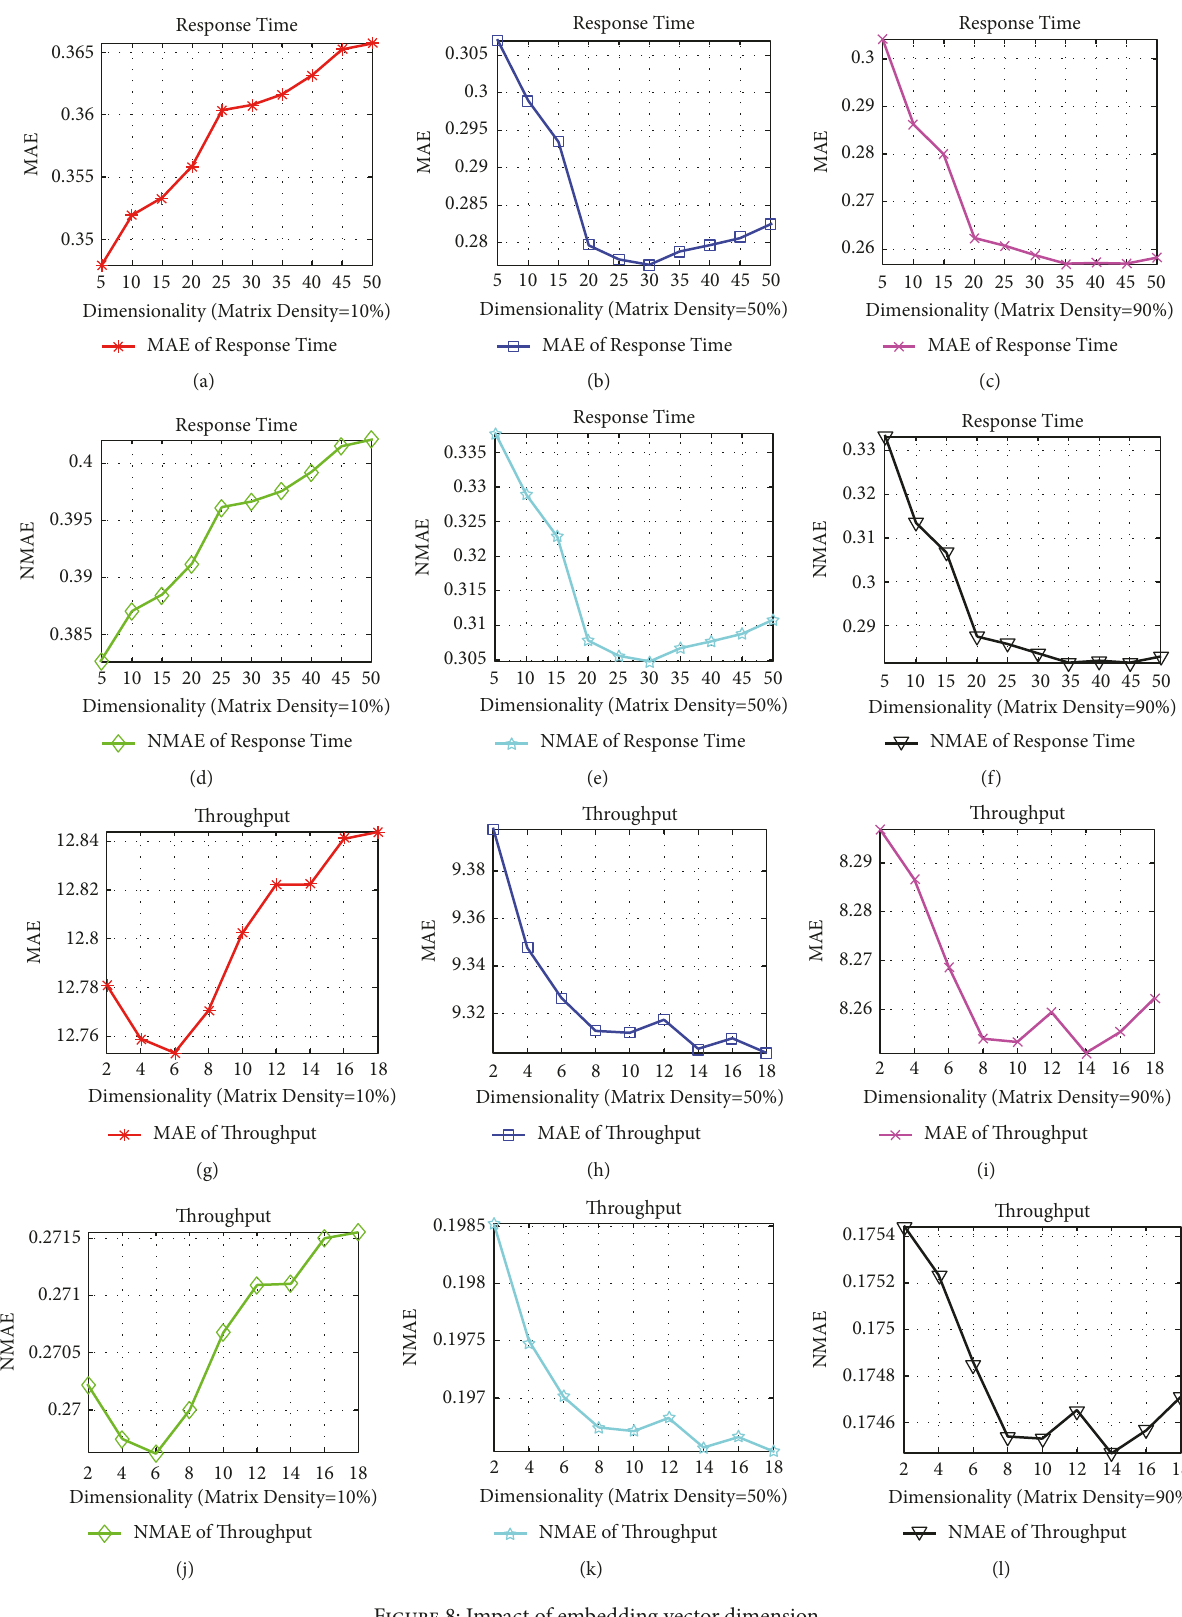
Figure 8: Impact of embedding vector